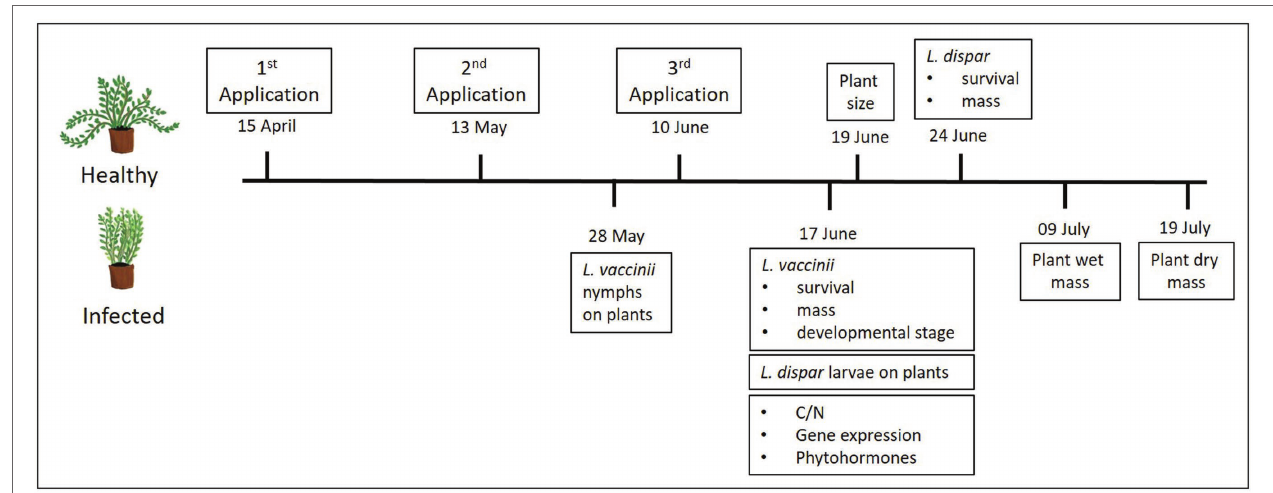
FIGURE 1 | Timeline showing the dates of elicitor applications, insect performance assays, and plant measurements and tissue sampling.